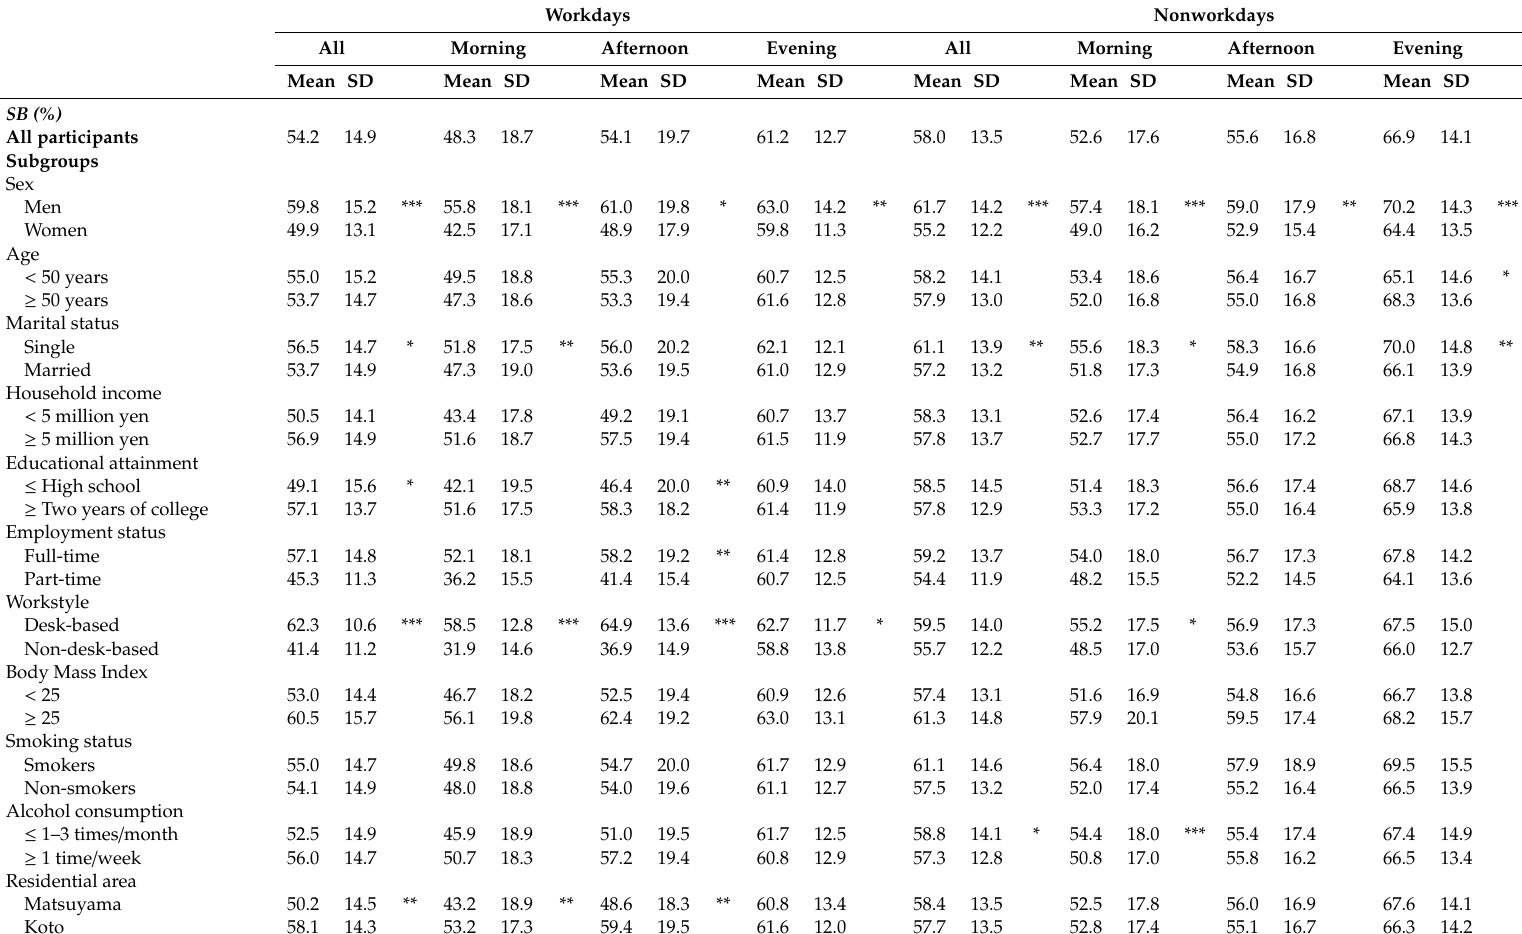
Table 2. Patterns of objectively measured sedentary